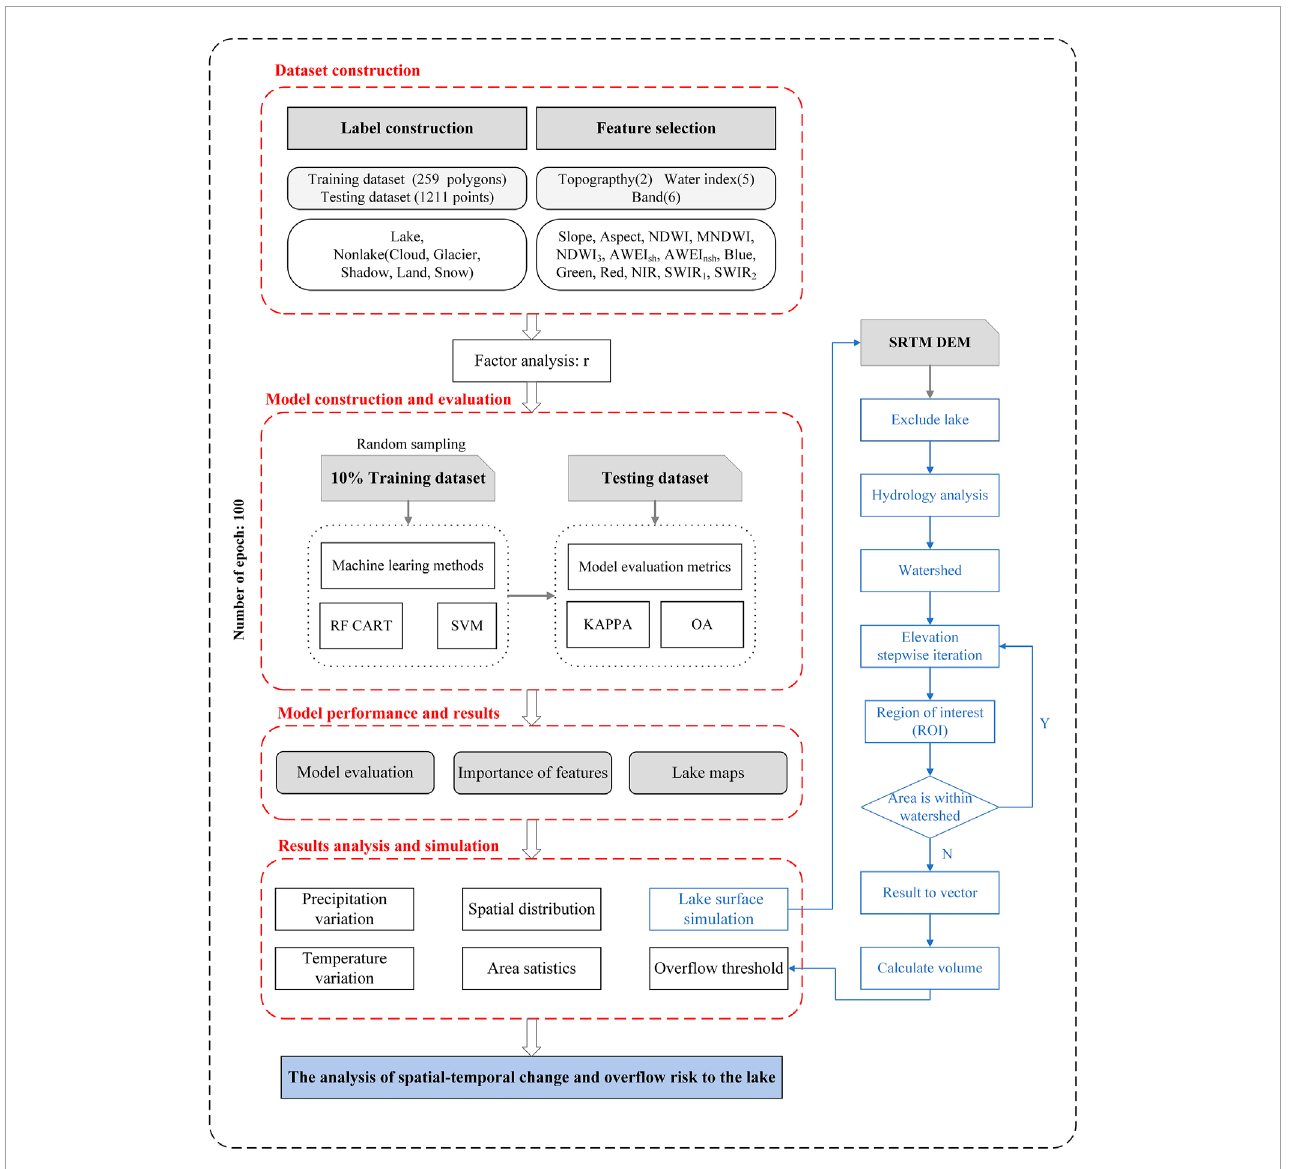
FIGURE 3 Flowchart of the proposed methodology for water extraction in this